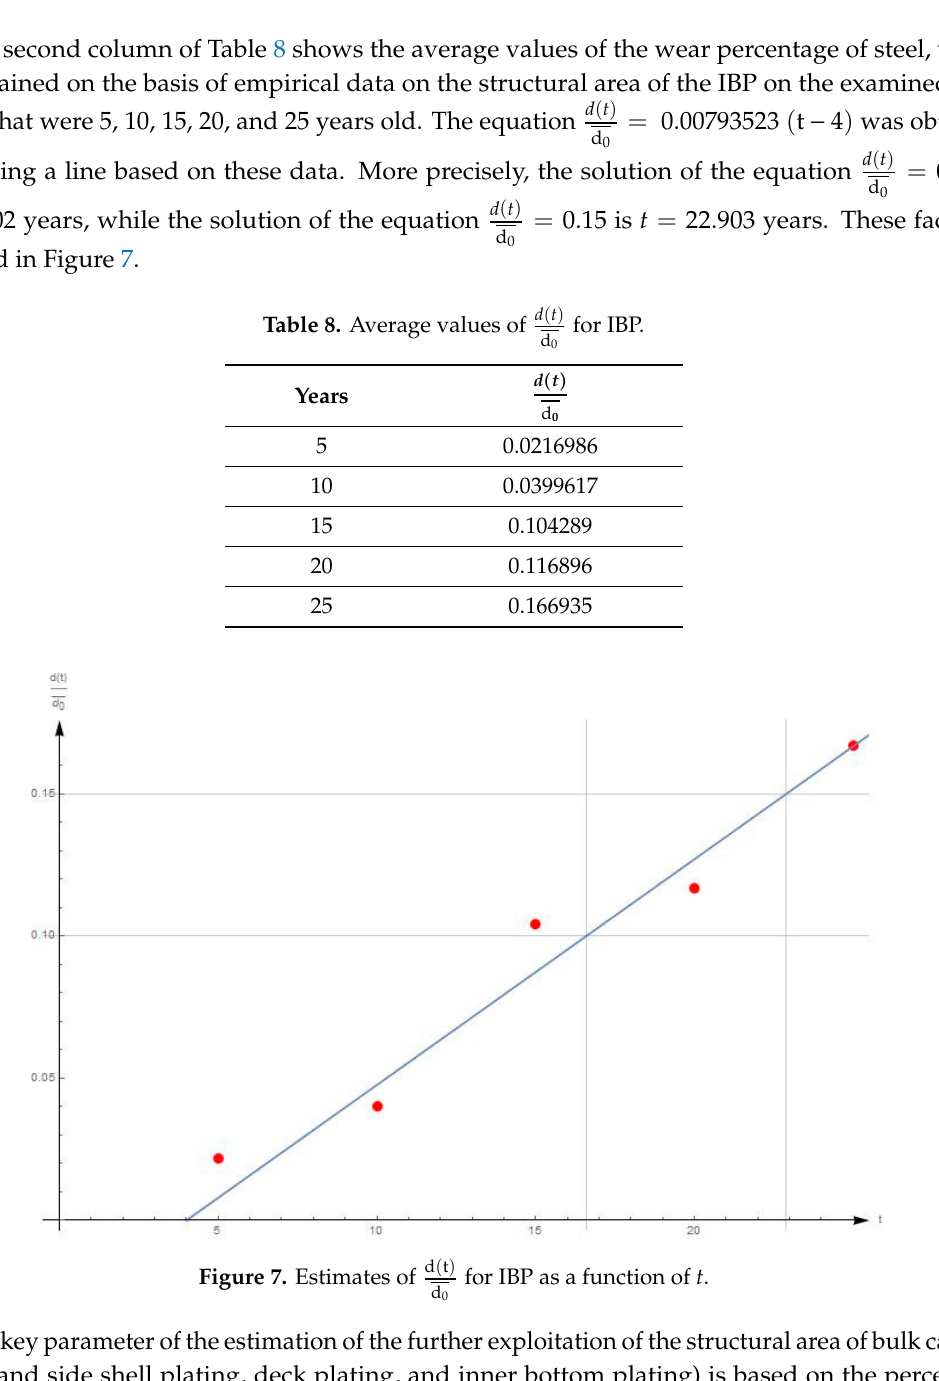
Table 7. Test statistical values for the best fitted three-parameter distributions.